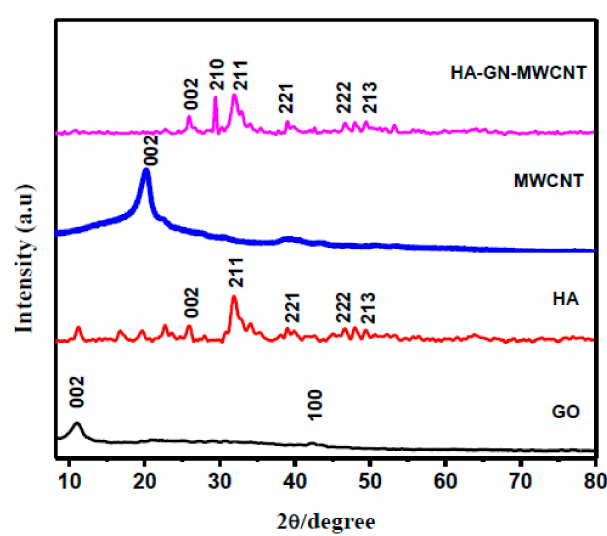
Figure 4. XRD patterns of HA-GN-MWCNT composite sample and single components.